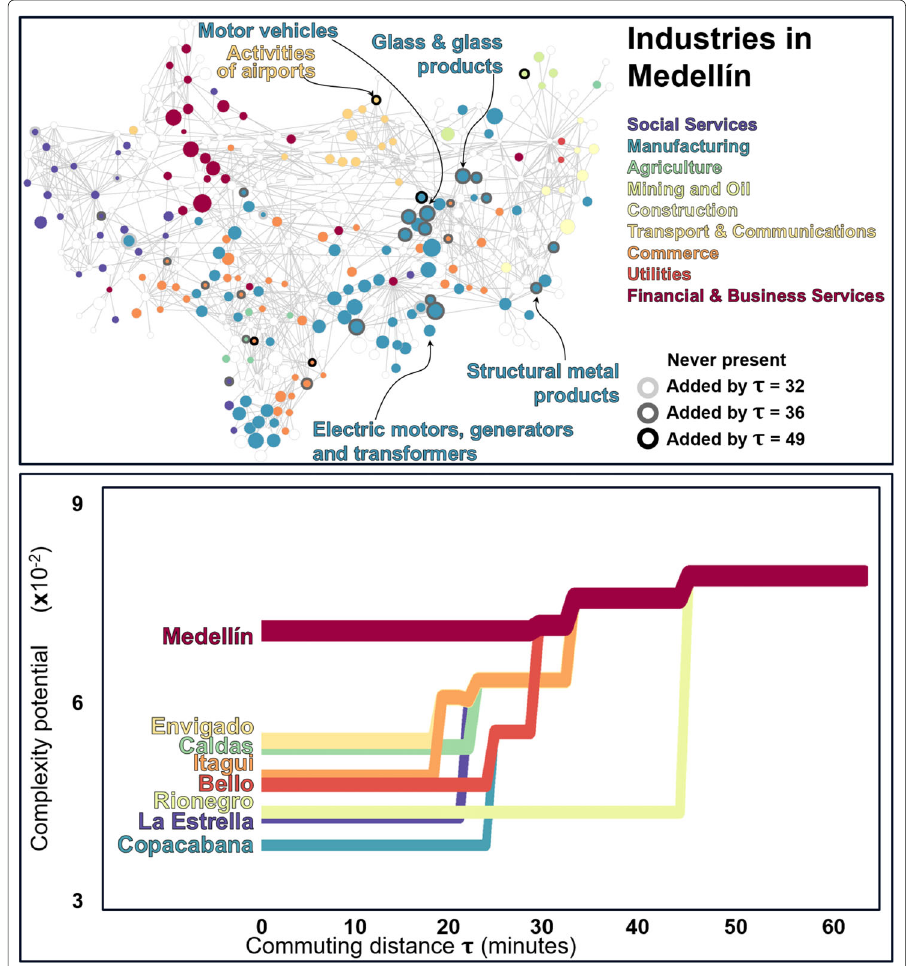
Fig. 8 The top panel highlights the network location of industries present in Medellín. The value of τ at which an industry is “added” is shown via the width of the node rim. By time τ = 49 minutes, 30 industries are considered to be present which were not at τ = 0. The panel below shows the complexity potential of Medellín and its surrounding municipalities as the commuting time τ increases. We observe that, for example, when τ = 49 minutes, Rionegro is considered to be part of Medellín and so they merge into